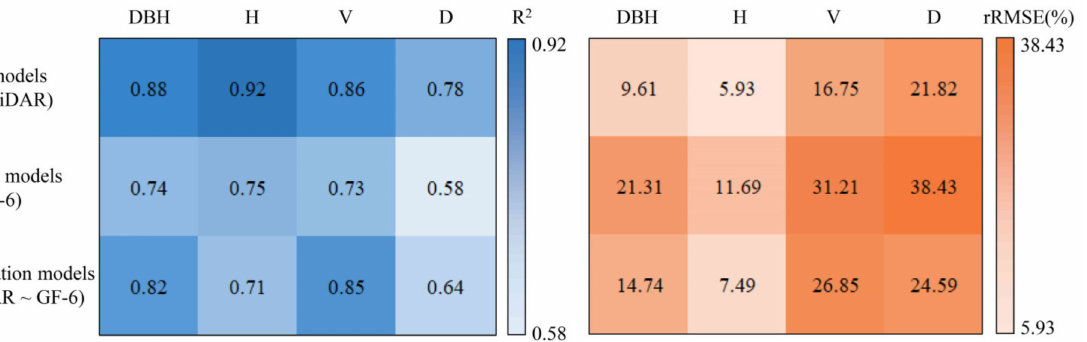
Figure 5. The estimation results of forest structural parameters using UAV-LiDAR models, direct prediction models, and two-stage extrapolation models,